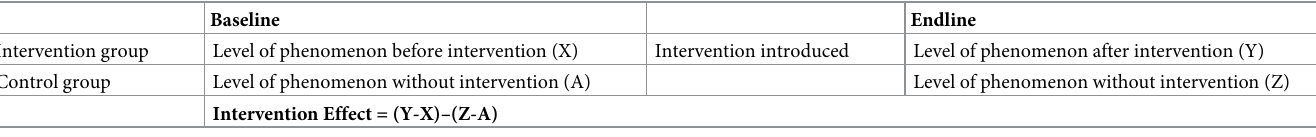
Table 1. Intervention effect